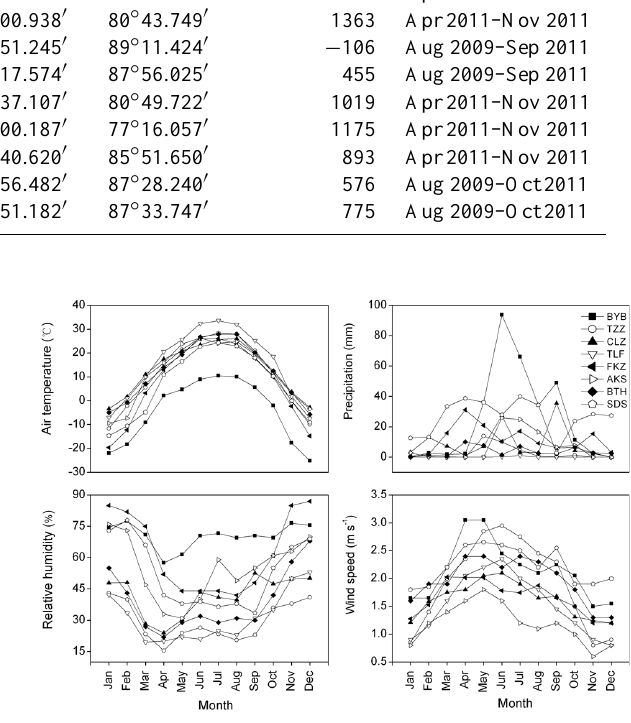
Fig. 2. Air temperature, precipitation, wind speed and relative